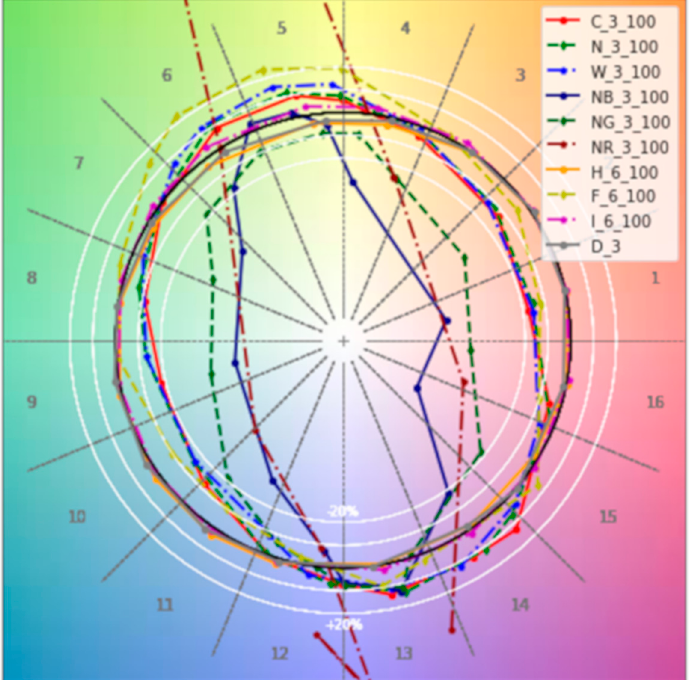
Figure 13. The 16 hue bins circle for different lighting sources: incandescent—I_6_100,